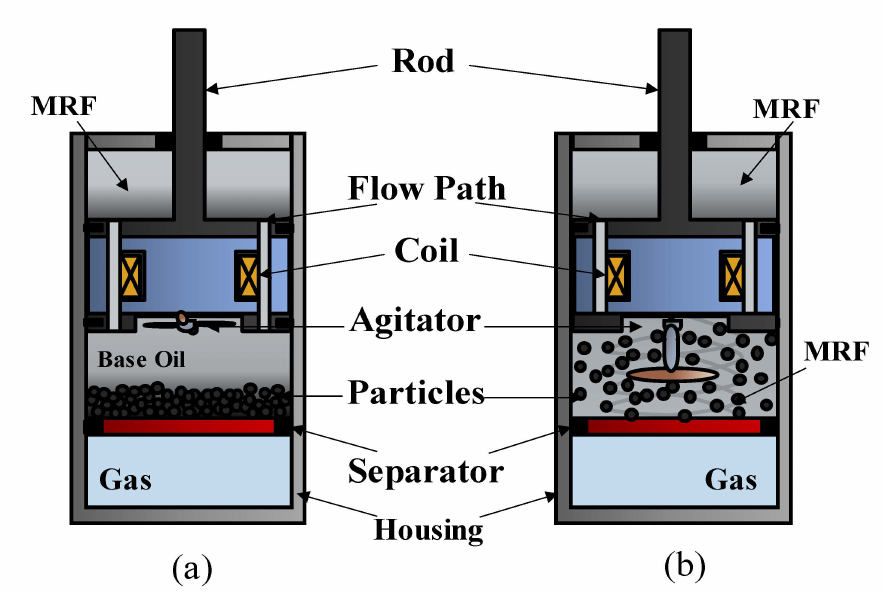
Figure 7. Conceptual method to disperse the settled particles in MR damper that has rested for a long time without operation; ( a ) no operation for a long time; ( b ) starting operation after long